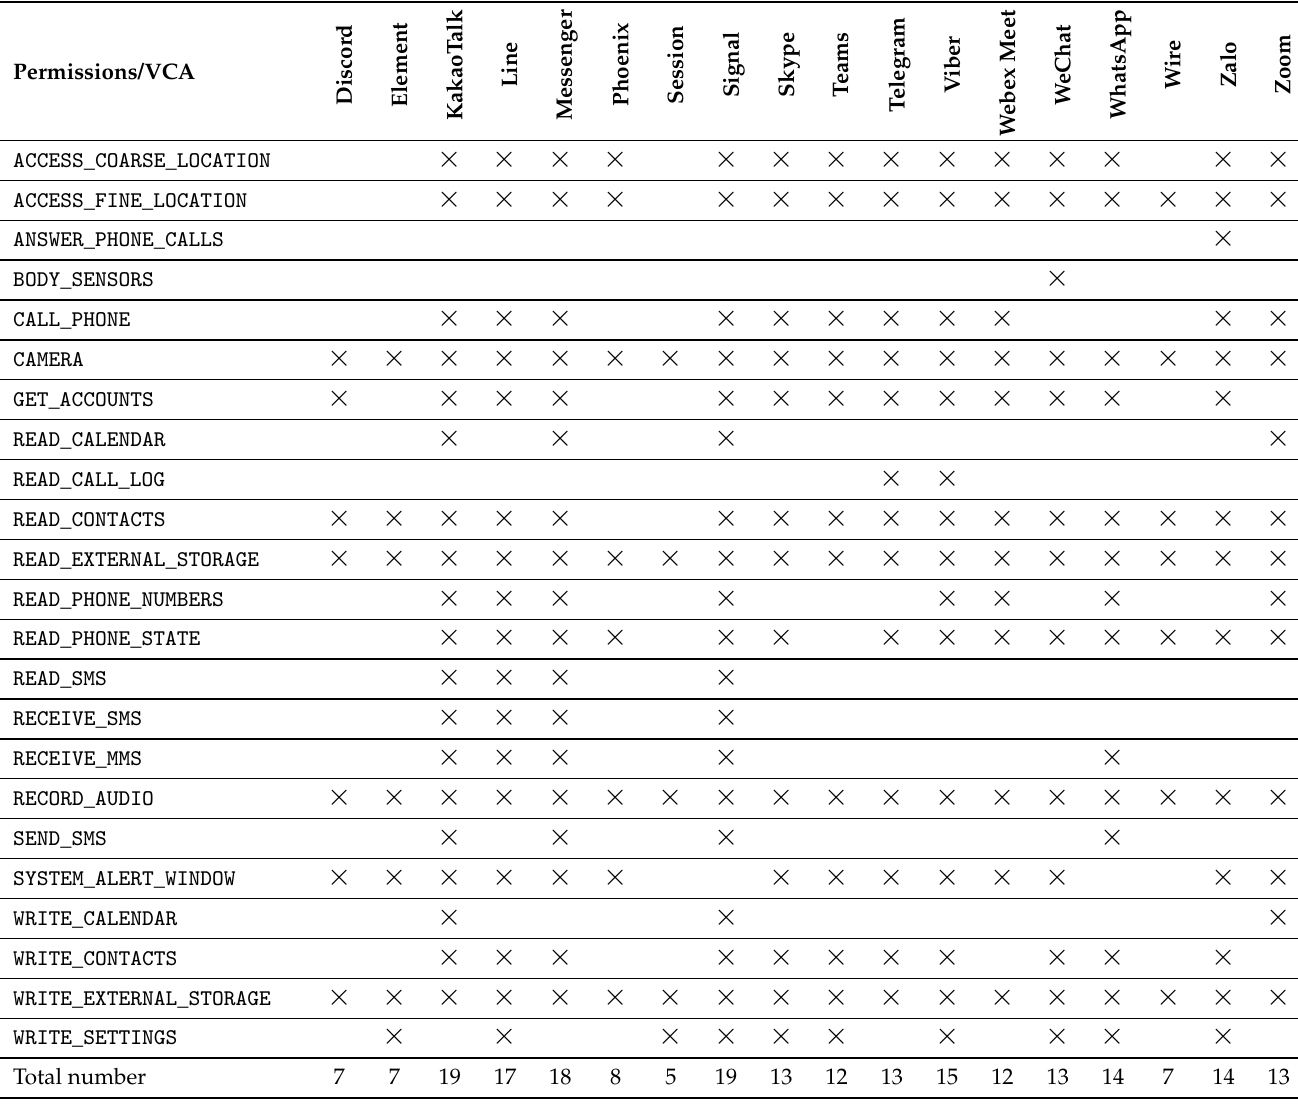
Table 1. Dangerous permissions obtained by video conferencing apps (where × denotes the relevant permission being